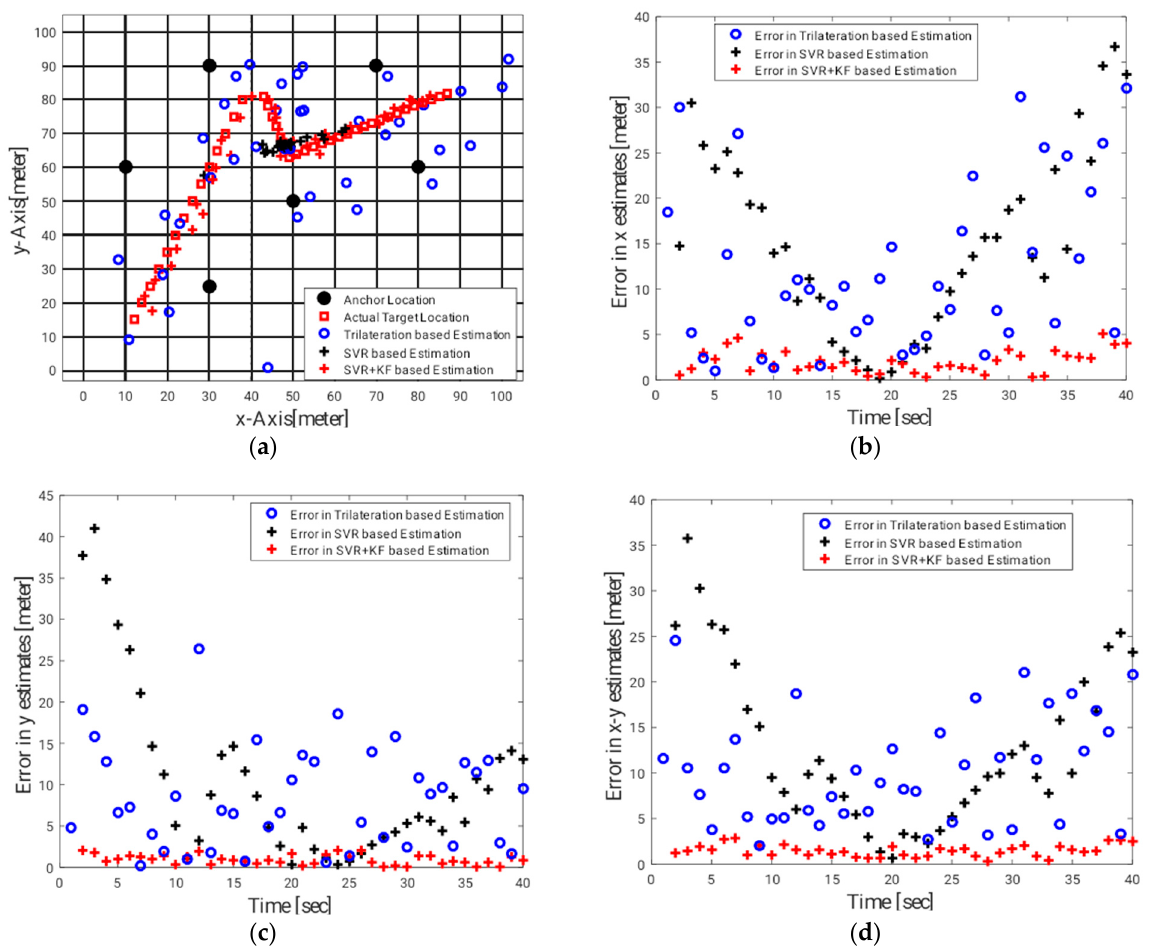
Figure 6. Case III: impact of the RBF Kernel on SVR-based target localization. ( a ) Location estimates with trilateration, SVR, and SVR+KF against the actual target trajectory, ( b ) localization error with trilateration, SVR, and SVR+KF along the x direction, ( c ) localization error with trilateration, SVR, and SVR+KF along the y direction, ( d ) localization error with trilateration, SVR, and SVR+KF along the x–y direction.